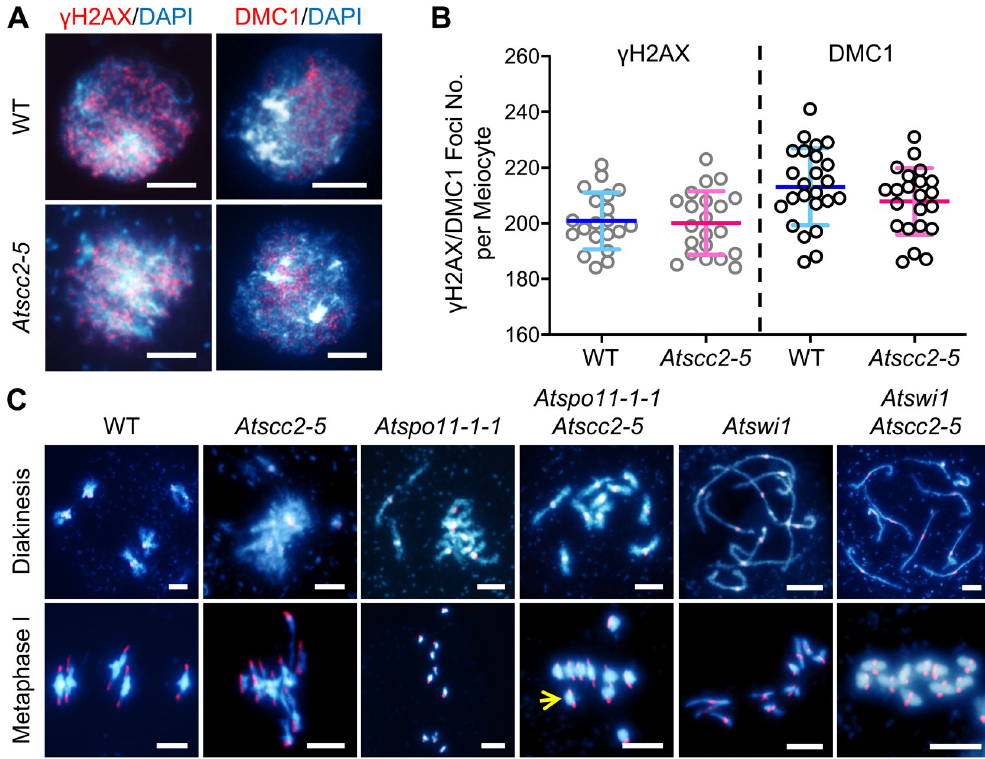
Fig 4. AtSCC2 is dispensable for DSB formation but is indispensable for AtSPO11-1-dependent DSB repair. (A) Localization of γ H2AX and DMC1 in WT and Atscc2-5 zygotene male meiocytes. Bar = 5 μ m. (B) Plots of the γ H2AX and DMC1 foci numbers in WT and Atscc2-5 zygotene male meiocytes (two-tailed Student’s t test). (C) Fluorescence in situ hybridization of WT, Atscc2-5 , Atspo11-1-1 , Atspo11-1-1 Atscc2-5 , Atswi1 , and Atswi1 Atscc2-5 double mutant chromosomes using centromere probes. Yellow arrows indicate the separated centromeres of sister-chromatids at metaphase I. Bar = 5 μ m.